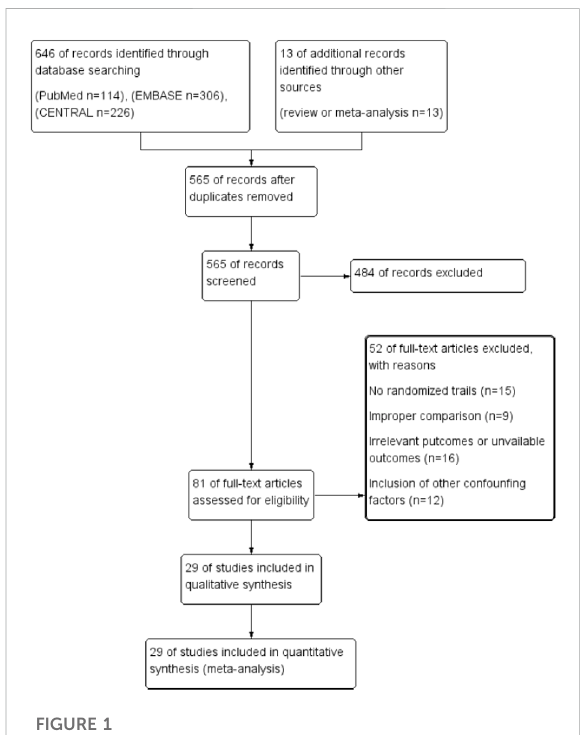
FIGURE 1 Flowchart of literature search and study